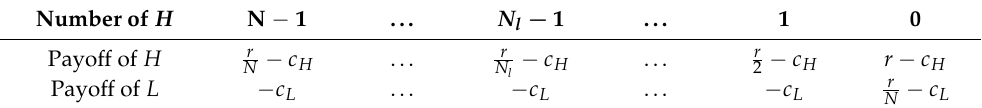
Table 2. Payoff matrix of